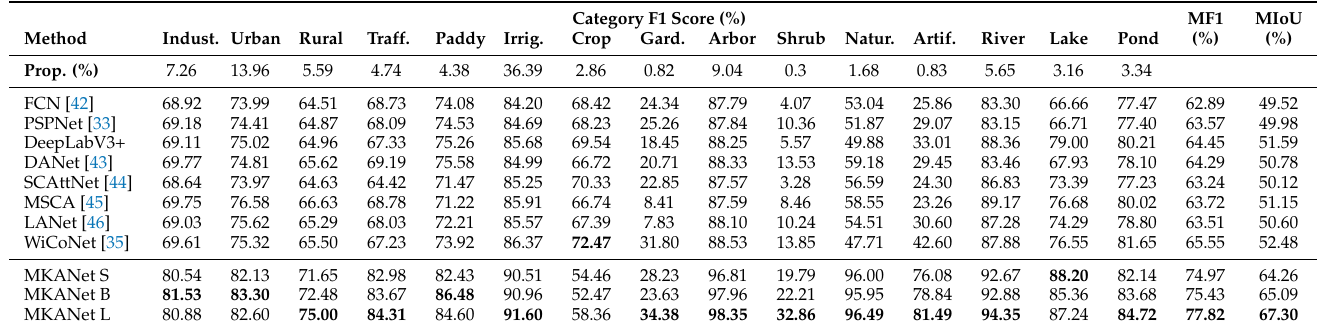
Table 7. Comparison of MKANets with large networks on the GID